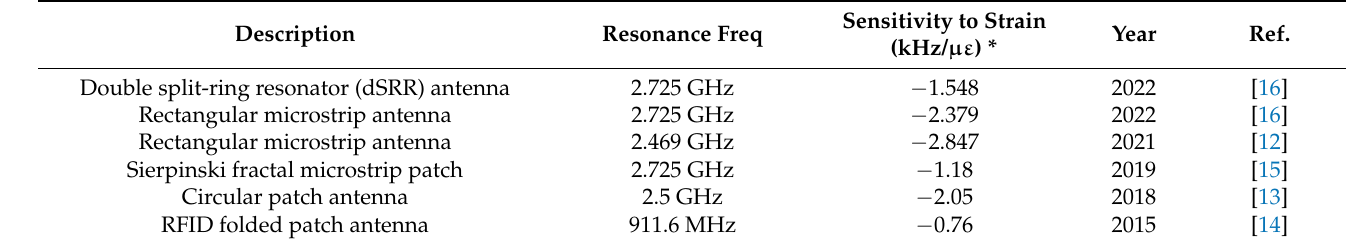
Table 5. Comparison of recent works on antenna sensors for structural health monitoring.